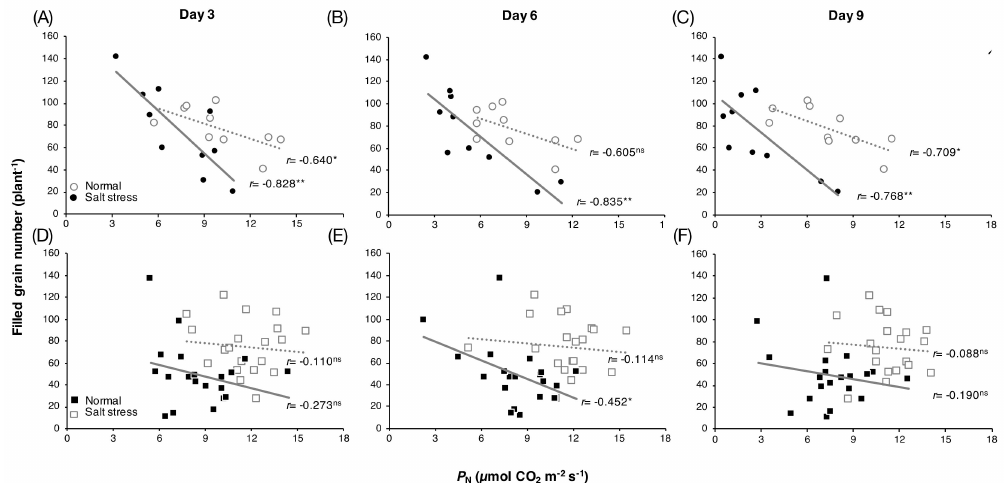
Figure 2. Correlation between leaf P N and grain yield per plant of group I rice ( A – C ) and group II rice ( D – F ) grown under normal and salt stress conditions for 3, 6 and 9 days, respectively. *significant at p -value < 0.05, **significant at p -value < 0.01, and ns = not